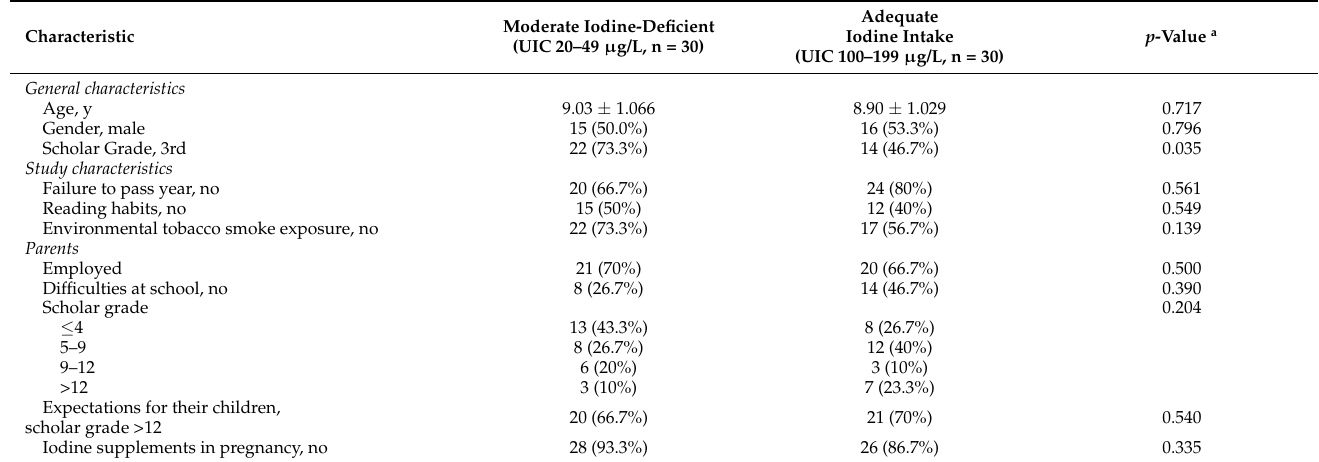
Table 1. Characteristics of the two studied subgroups: Moderate Iodine Deficiency vs. Adequate Iodine